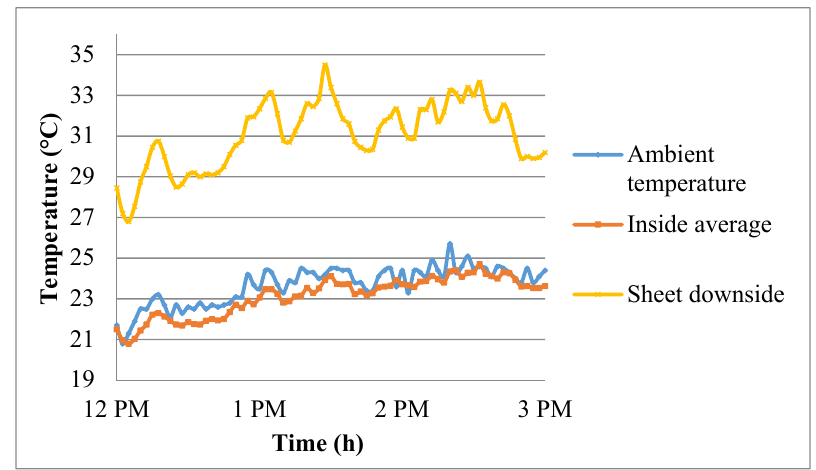
Figure 11. Time dependence of roof sheet temperature and ambient temperature for real cowshed without installation of photovoltaic modules on the roof.